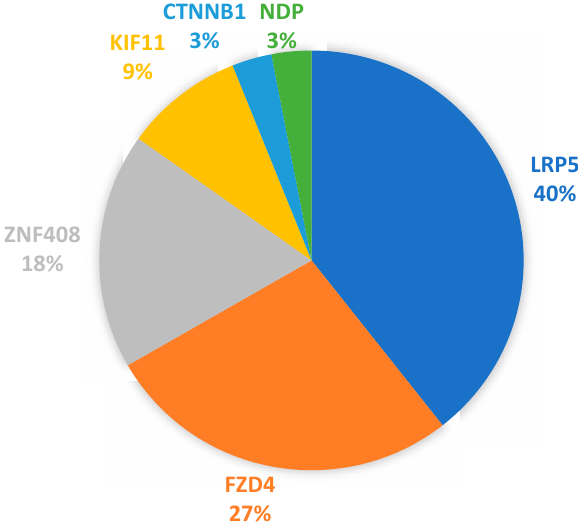
Figure 3. Gene distribution of protein sequence variants detected in the FEVR cohort. Of the 33 protein-altering variants listed in Table 4, the distribution by gene was as follows: LRP5 13/33 (40%), FZD4 9/33 (27%), ZNF408 6/33 (18%), ( KIF11 3/33 (9%), NDP 1/33 (3%), CTNNB1 1/33 (3%).